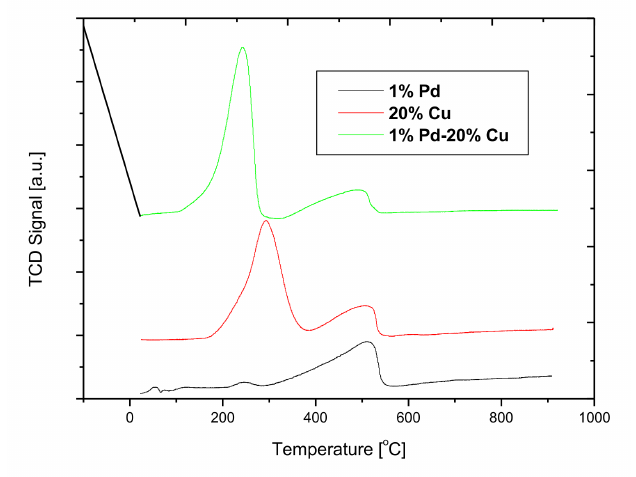
Figure 3. The TPR-H 2 of the monometallic (Cu, Pd) and bimetallic Pd-Cu catalysts supported on MWCNTs.